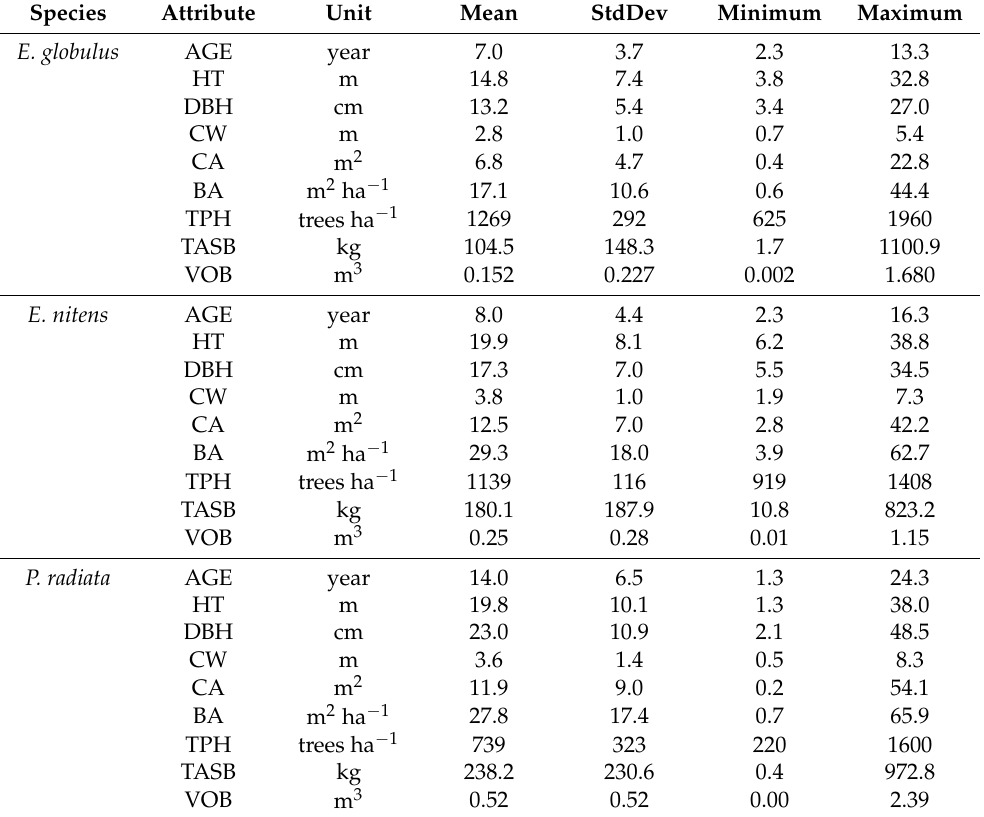
Table 1. Summary statistics of measured E. globulus ( n = 200), E. nitens ( n = 119), and P. radiata ( n = 316, trees. Species Attribute Unit Mean